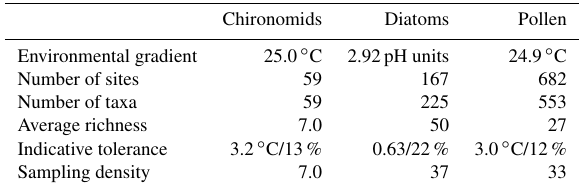
Table 1. Training-set